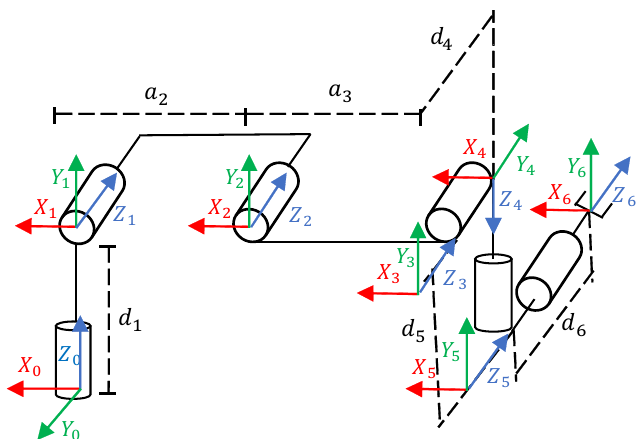
Figure 2. Coordinate system of the main manipulator